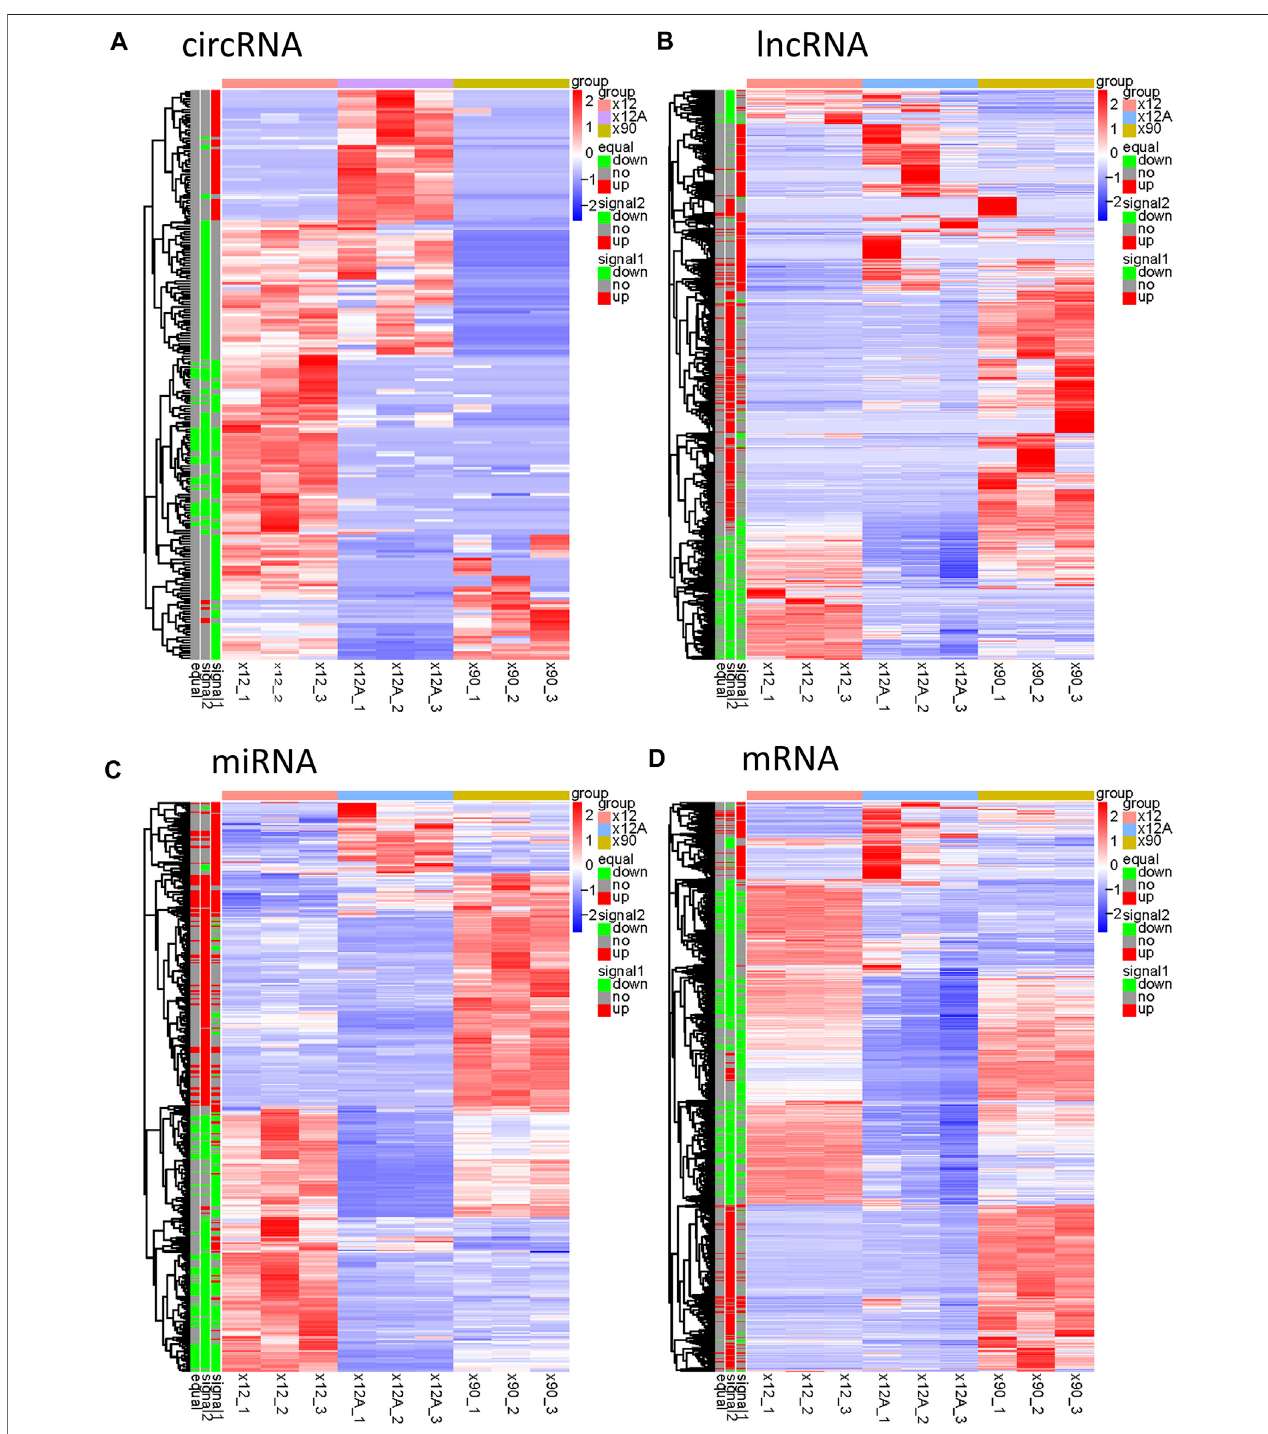
FIGURE 2 | Hierarchical clustering and heat map analysis of differentially expressed RNAs. (A) circRNAs, (B) lncRNAs, (C) miRNAs, and (D) mRNAs in A β -treated and 90 day-cultured astrocytes in vitro. circRNA, circular RNA; lncRNA, long non-coding RNA; miRNA, microRNA; mRNA, messenger RNA. In the left legend, equal: genes that changed in both x12 and x90 groups together, signal1: genes that changed in the x12 group, signal2: genes that changed in the x90 group, red indicates upregulation, green indicates downregulation, and gray indicates insigni fi cant change. The data were based on the prede fi ned thresholds (padj < 0.05, | log2FC| >